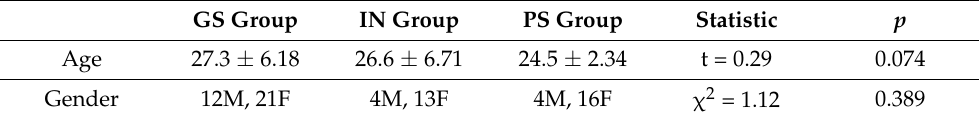
Table 1. Age and gender distribution in the three groups.